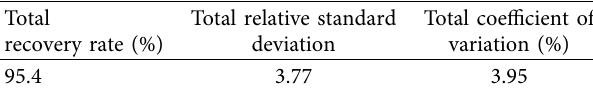
Table 3: Total elaboration of 18 spiked feed samples. Total